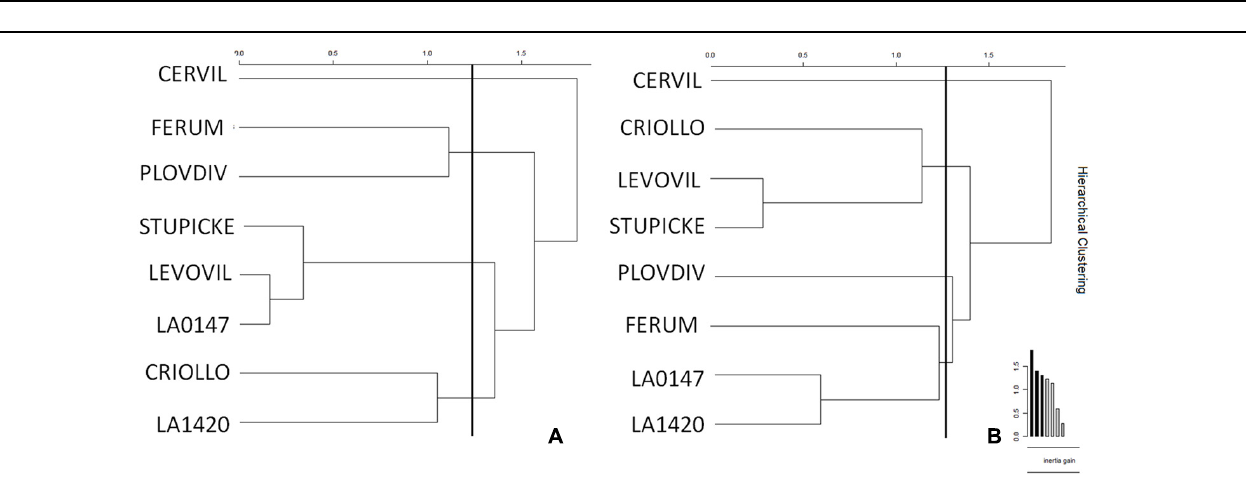
FIGURE 4 | Partial correlation network for plant and fruit composition [DM content, fruit fresh weight (FW), soluble sugars, organic acids, carotenoids, and AsA contents] and physiological parameters (the maximum quantum efficiency of PSII ( F V / F M ), the PI of Strasser and the quantum yield of the electron transport flow until PSI acceptors ( J 0RE1 / J ABS ). Partial correlations were calculated on AUCs for plant measurements and for S2 fruits ( n = 5, 80 plants) under (A) control and (B) WD conditions. The network was built using GGMselect, GeneNet, and igraph packages on R. Solid lines indicate positive correlations between parameters whereas dotted lines indicate negative correlations ( P < 0.001).